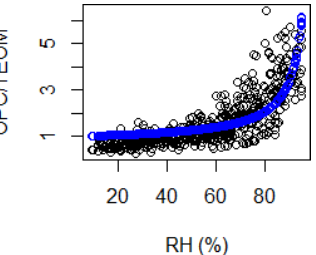
Figure 7. Humidograms for Delhi using the normalized OPC-N2 PM 2 . 5 mass concentrations with the corresponding κ